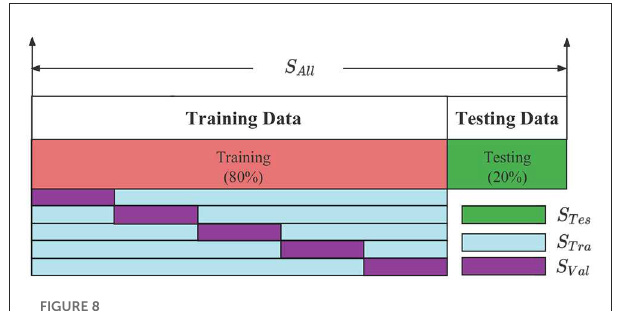
FIGURE8 The S Tra , S Val , S Tes division of BECT data.